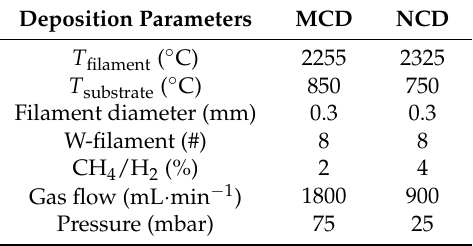
Table 1. Hot filament deposition parameters of each micro- and nanocrystalline diamond (MCD/NCD) layer. Deposition